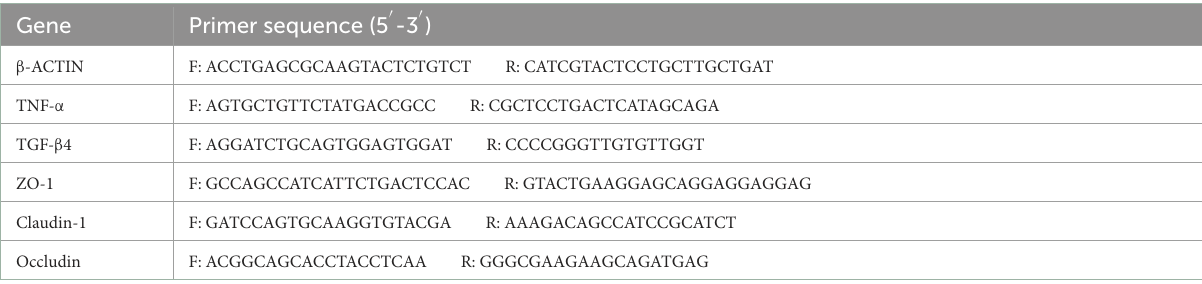
TABLE 2 Primers used for quantitative real-time polymerase chain reaction (PCR) in this study. Gene Primer sequence (5